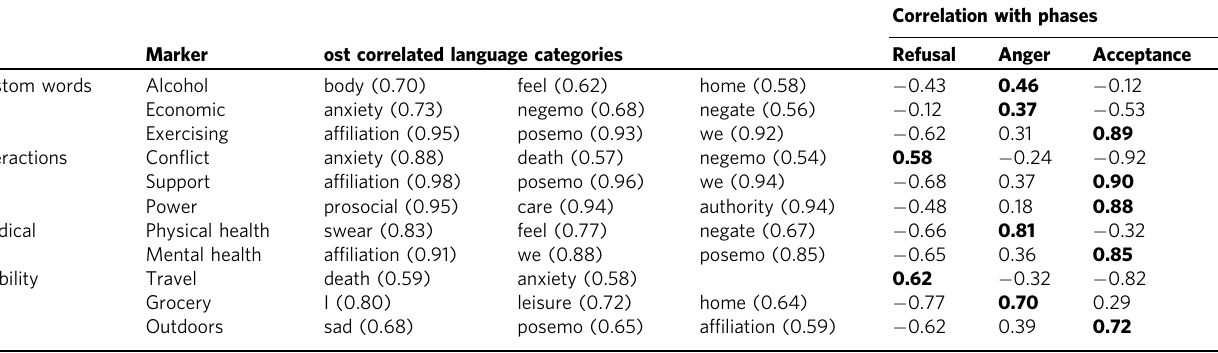
Table 3 (Left) Correlation of our language categories with behavioral markers computed with alternative techniques and